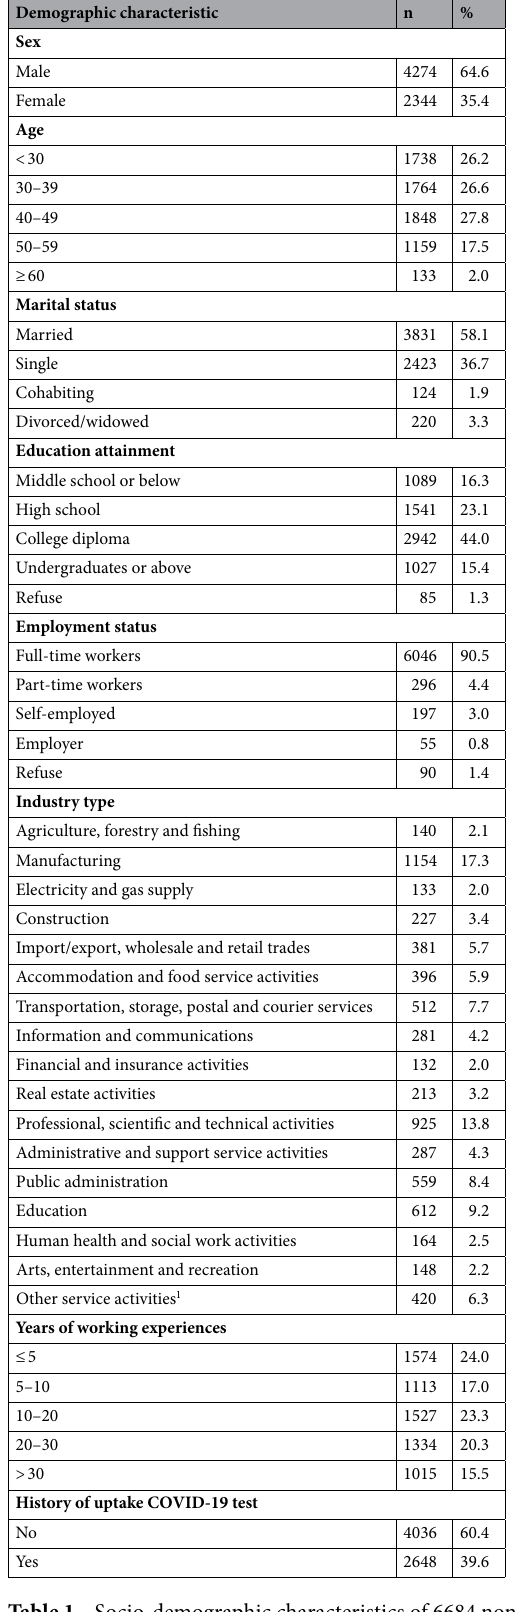
Table 1. Socio-demographic characteristics of 6684 non-healthcare workers from Hong Kong, Nanjing and Wuhan of China. 1 Other service activities including: Other service activities, Mining and quarrying, Water supply; sewerage, waste management and remediation activities, and Work activities within domestic households